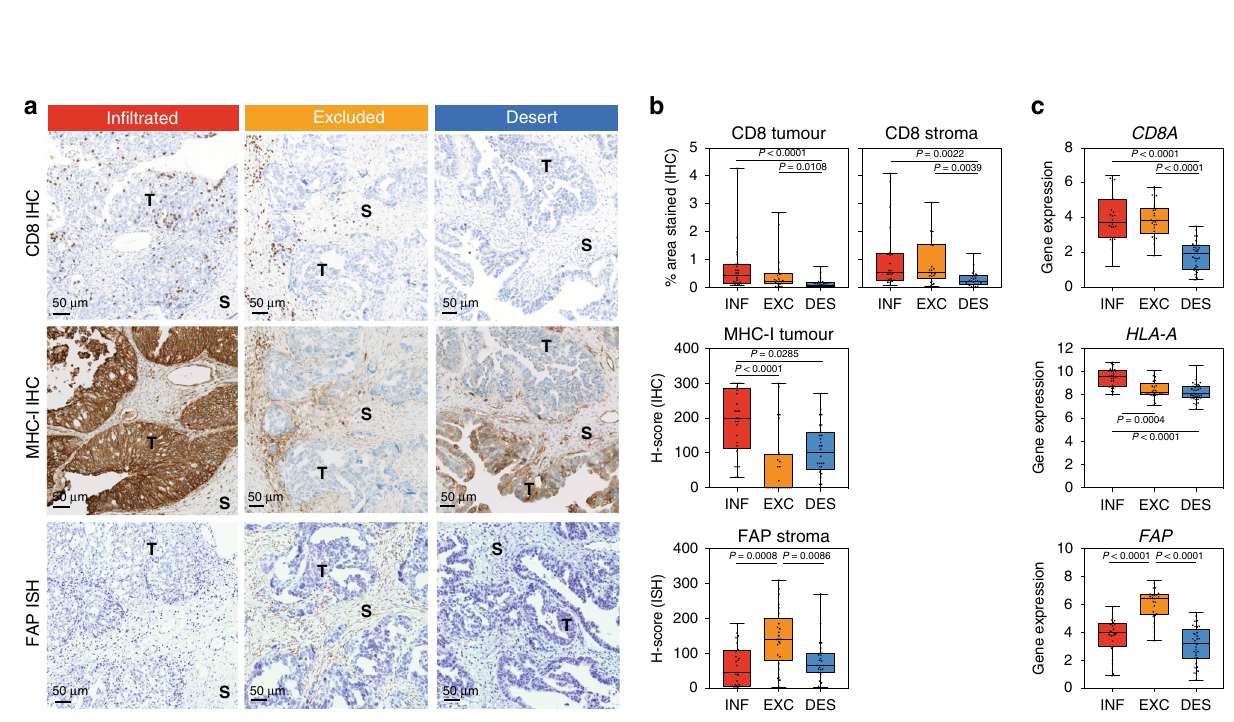
Fig. 4 In situ validation of key features of T-cell excluded tumours. The tumour-immune phenotypes for a vendor-procured collection (including both primary tumours and recurrent tumours, n = 84 samples) were predicted based on gene expression. The pattern of CD8 + T-cell in fi ltration and molecular features associated with excluded tumours were validated using immunohistochemistry and in situ hybridization (ISH) on FFPE tumour tissues. a Representative images of CD8 IHC (top), MHC-I-IHC (middle) and FAP ISH (bottom) are shown for the three tumour-immune phenotypes. b Percentage of CD8 staining over tumour/stroma area ( n = 72 samples), H scores for MHC-I ( n = 77 samples) and FAP expression in the tumour or the stroma ( n = 77 samples) were presented by the three-class tumour-immune phenotypes. c RNA-seq gene expression level, represented as Log 2 (RPKM + 1) for CD8A , HLA-A and FAP , is presented across the three-class tumour-immune phenotypes. b , c Whiskers ranging from minima to maxima, median and 25 – 75% IQR shown by boxplots; each dot is a tumour sample (primary tumours and recurrent tumours are pooled). The statistical signi fi cance is displayed with the exact P values on the graphs and calculated with a Kruskal – Wallis test corrected for multiple comparisons (Dunn ’ s test). Source data are provided as a Source Data fi